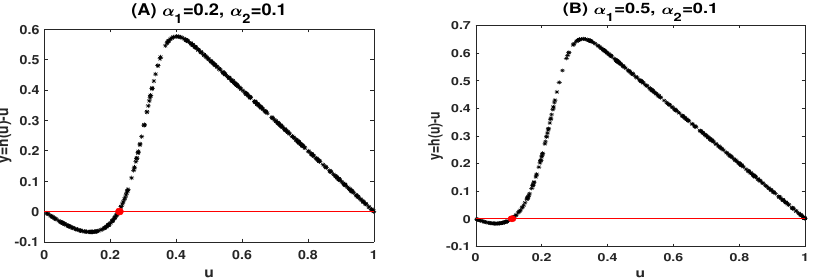
Figure 1. Numerical simulations displaying the dynamics of y = h ( u ) − u against u . Panel ( A ) is for the case with the release ratios α 1 and α 2 satisfying (i) in (17). And the release ratios in panel ( B ) meet (ii) in